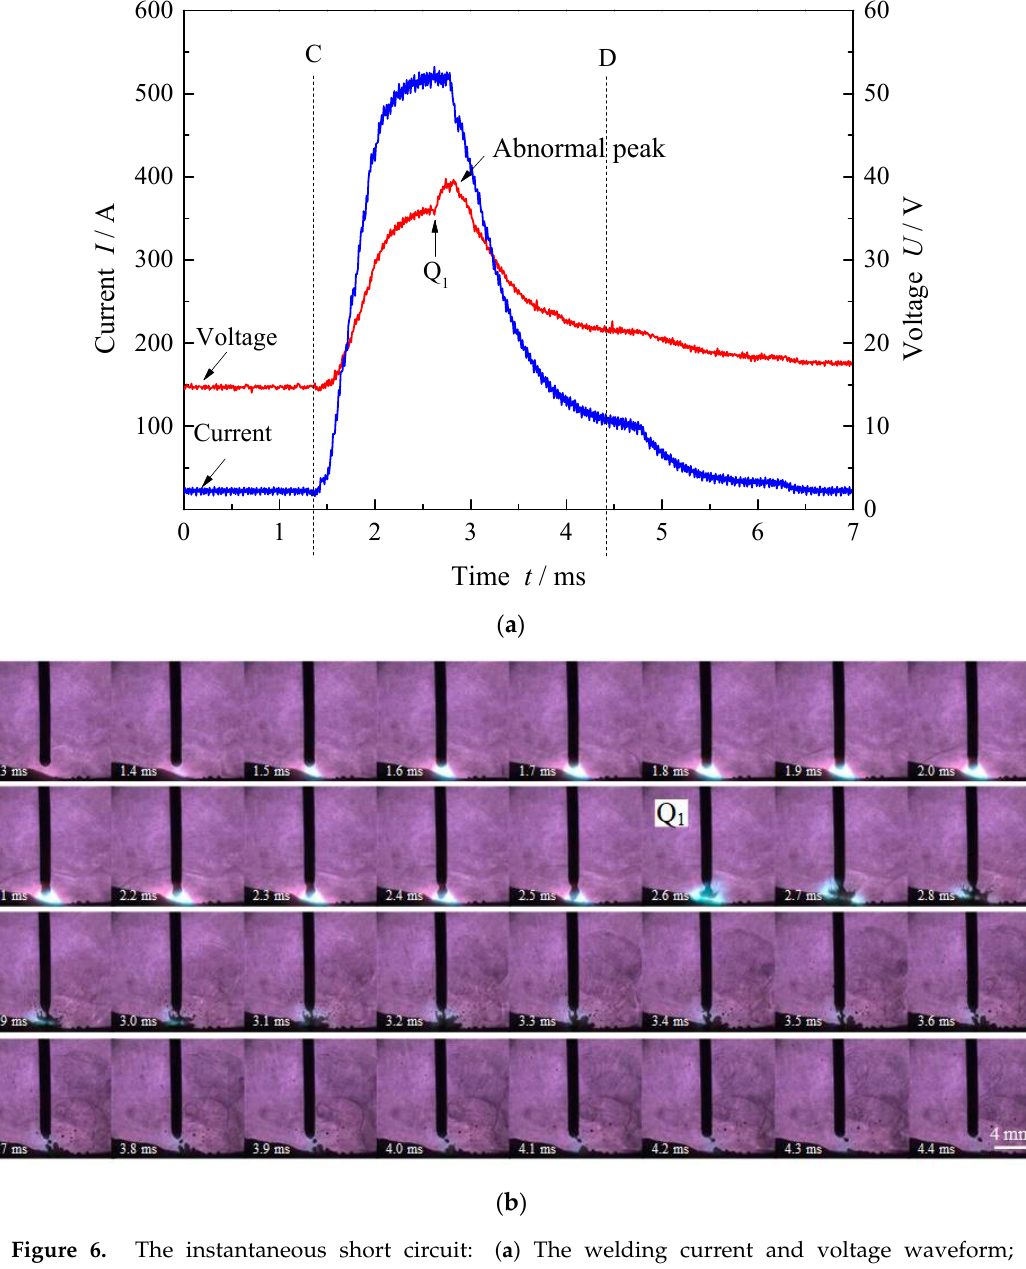
Figure 6. The instantaneous short circuit: ( a ) The welding current and voltage waveform; ( b ) the high-speed photographs of interval CD.